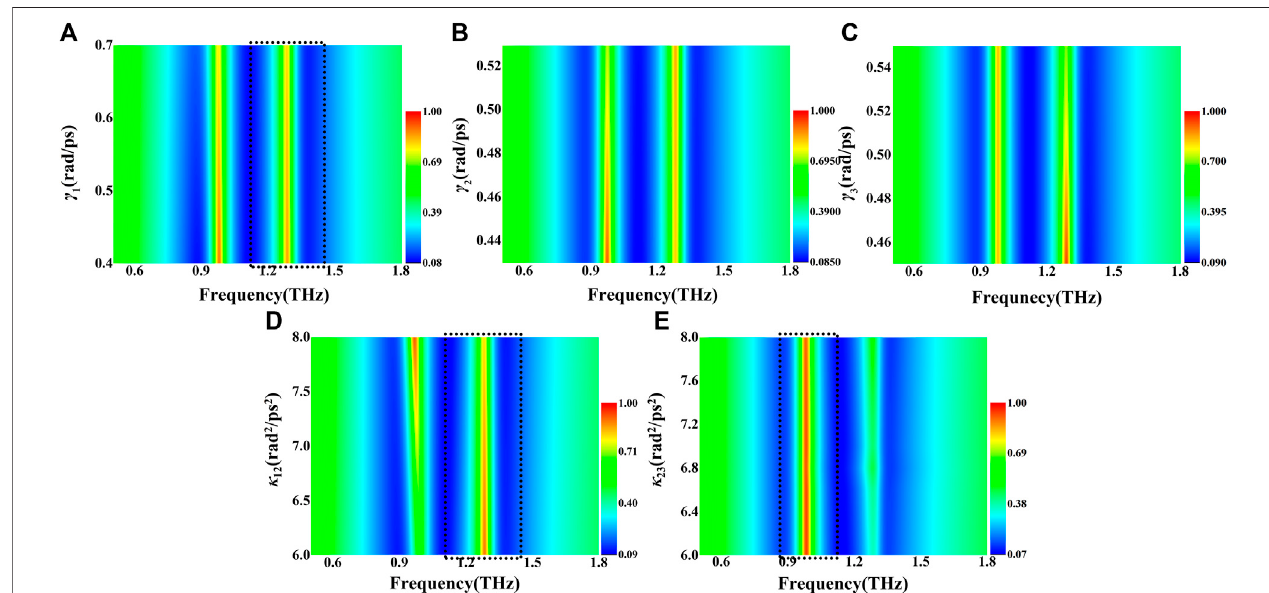
FIGURE 8 | Two-dimensional diagrams of the in fl uence of γ 1 (A) , γ 2 (B) , γ 3 (C) , κ 12 (D) , and κ 23 (E) on the transmission spectra.